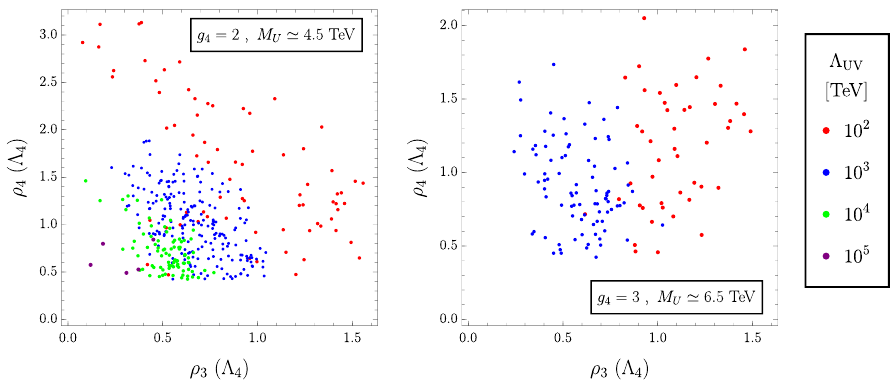
Figure 5 . Benchmark points in the ρ 3 (Λ 4 ) – ρ 4 (Λ 4 ) plane satisfying the UV conditions Eqs. (3.4) and (3.5) for different g couplings and unification scales Λ 4